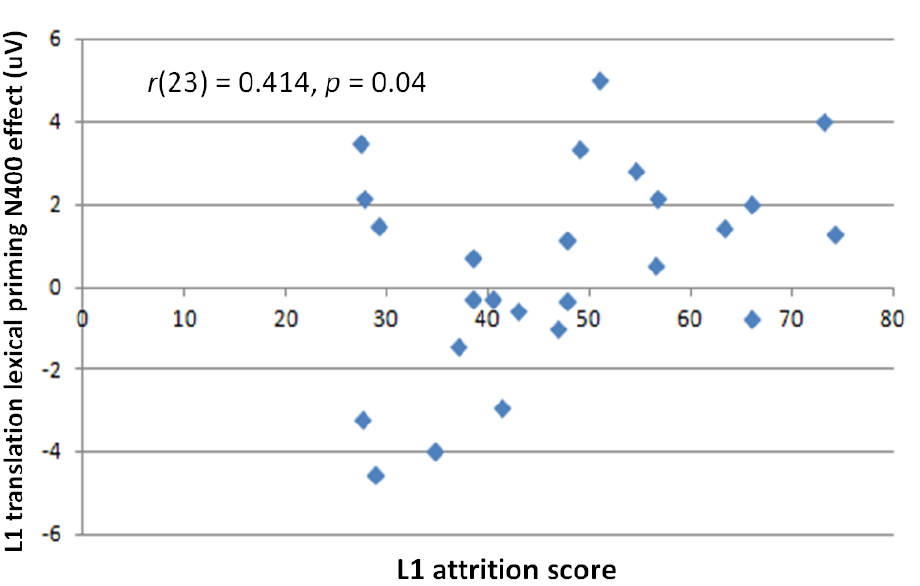
Figure 14. L1 translation lexical priming N400 effect against participant L1 attrition scores.